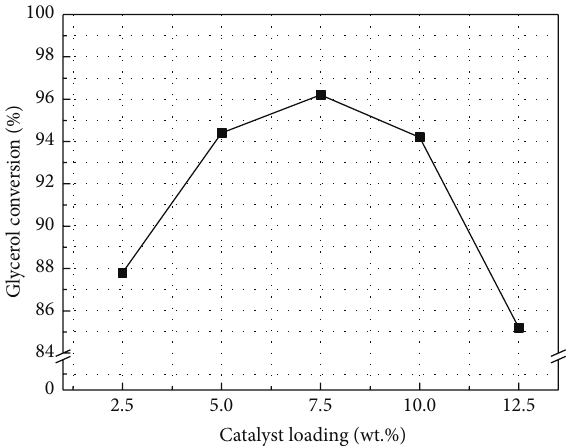
Figure 3: Influence of the catalyst loading on glycerol conversion. Reaction conditions: 70 ∘ C, TBA to glycerol molar ratio = 4: 1, and 8 hours.